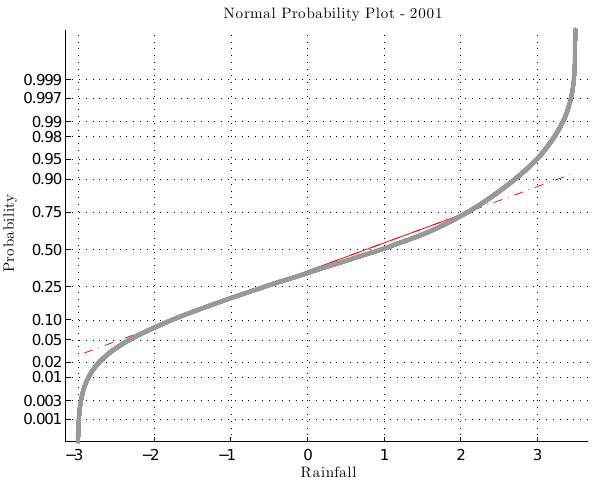
Figure 5. Lognormal test of ANUSPLIN data outcomes for the en- tire 2001